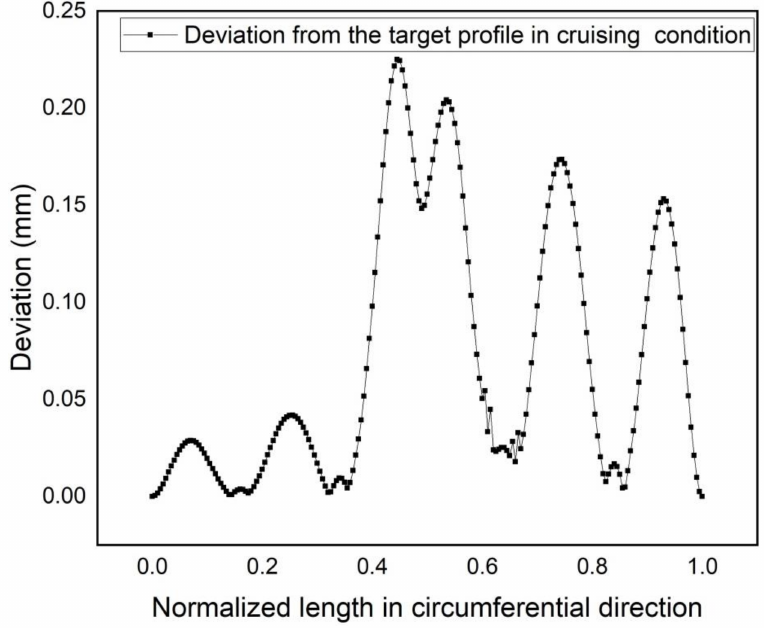
Figure 21. Deviation of the final profile from the target one in cruising flight